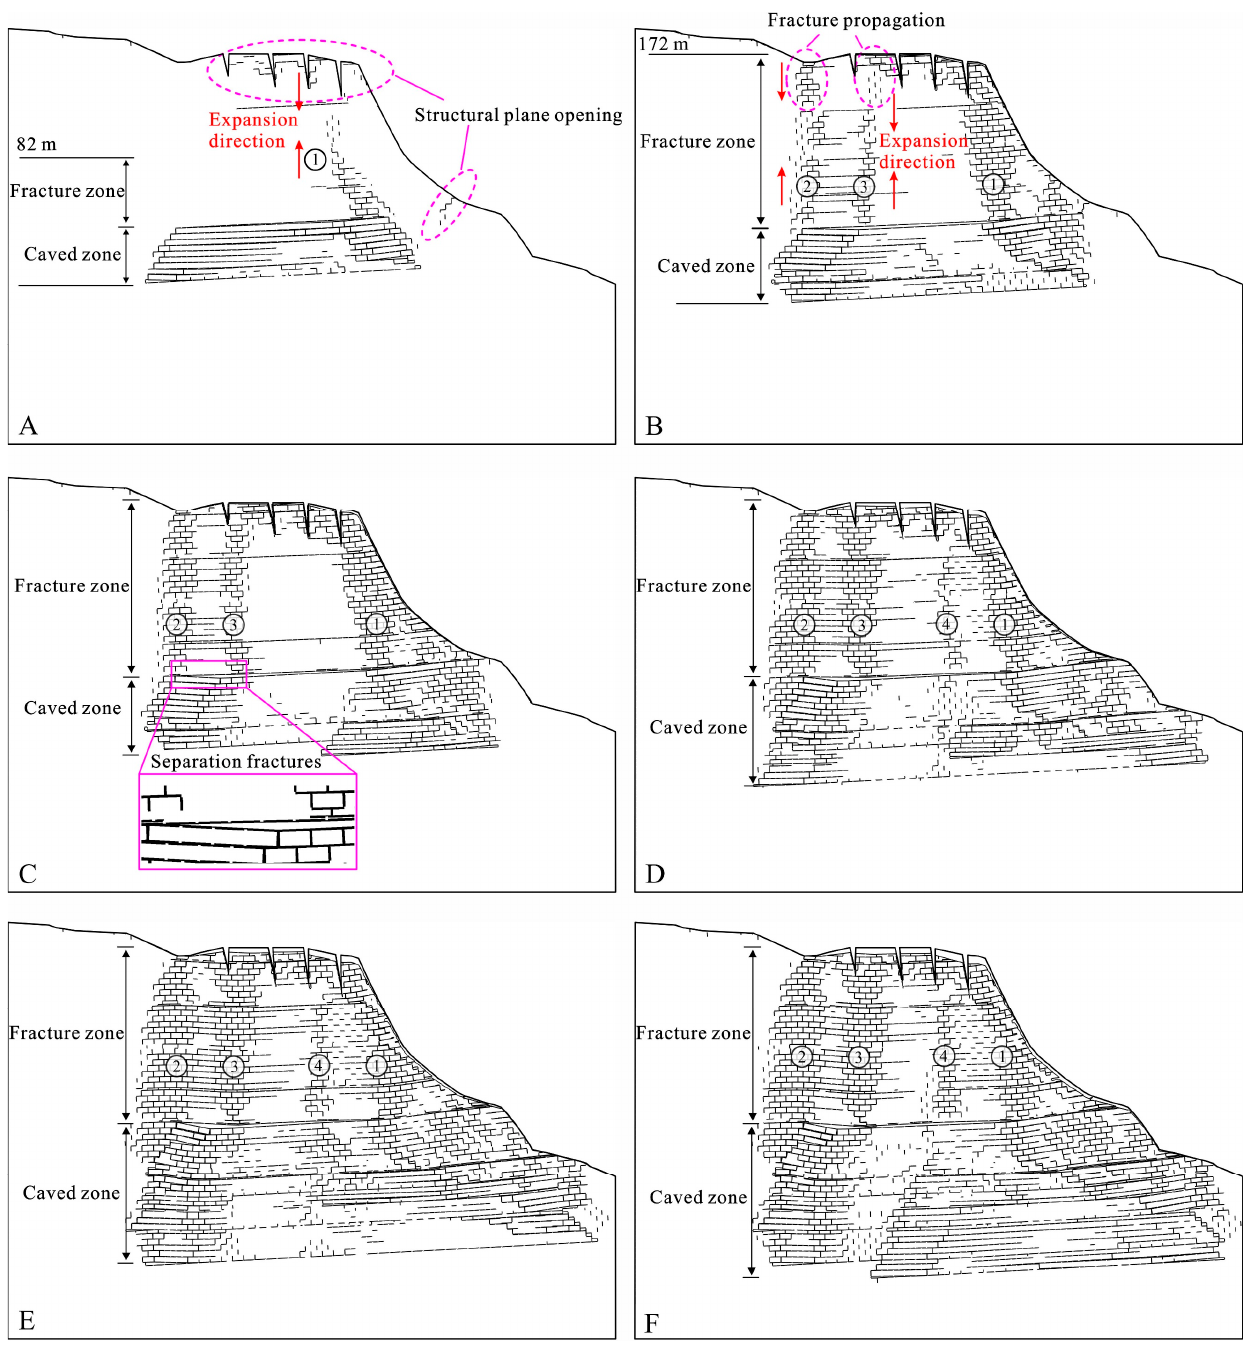
Figure 19. Fracture propagation under underground mining conditions: ( A ) mining stages I − II; ( B ) mining stages I − IV; ( C ) mining stages I − VI; ( D ) mining stages I − VIII; ( E ) mining stages I − X; and ( F ) mining stages I − XII. ① − ④ indicate the sequence of formation of the deep and large fractures.